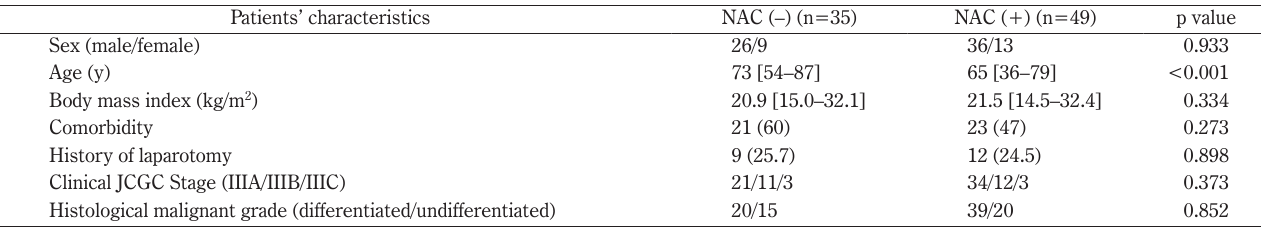
Table 1 Characteristics of all patients who underwent laparoscopic gastrectomy Patients’